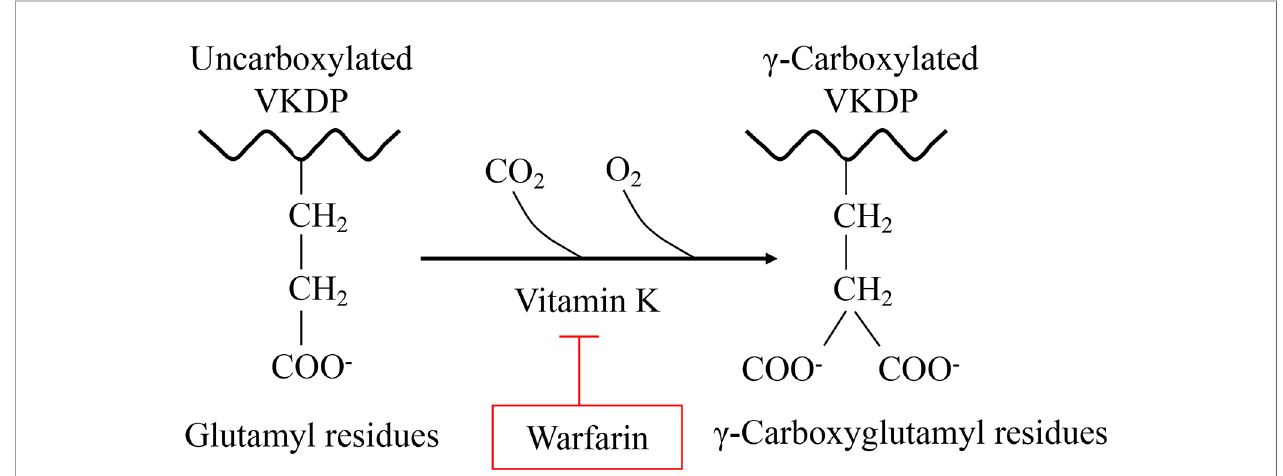
FIGURE 2 | VK is essential for the formation of Gla. Gla, a unique amino acid, is produced by a VK-dependent posttranslational modi fi cation of Glu in all Gla- containing proteins. This carboxylation process can be inhibited by